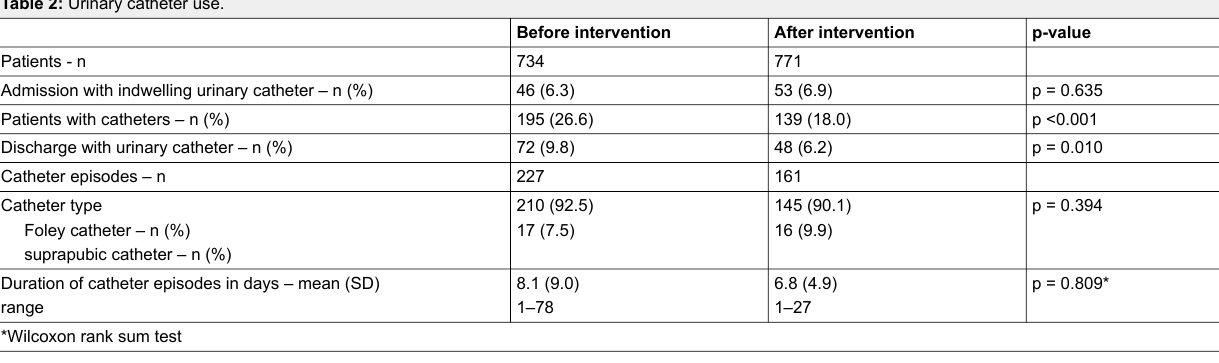
Table 2: Urinary catheter use.